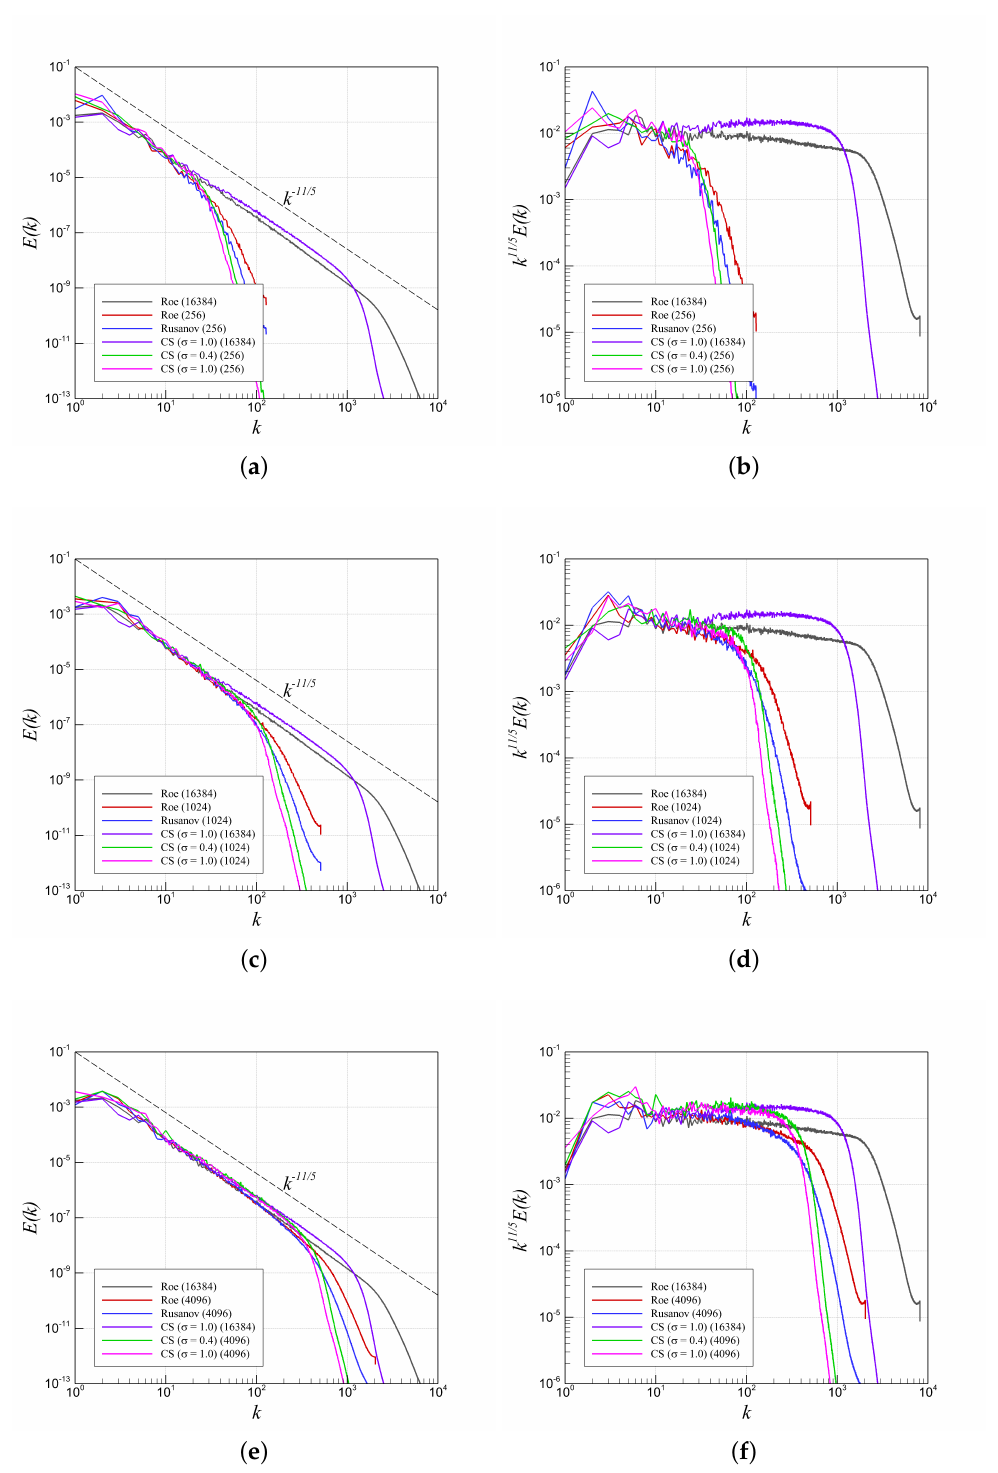
Figure 12. Comparison between ILES and CS+RF models for the RTI problem with multi-mode perturbation at different resolutions; ( a ) density-weighted spectra at 256 × 384 resolution; ( b ) compensated density-weighted spectra at 256 × 384 resolution; ( c ) density-weighted spectra at 1024 × 1536 resolution; ( d ) compensated density-weighted spectra at 1024 × 1536 resolution; ( e ) density-weighted spectra at 4096 × 6144 resolution; ( f ) compensated density-weighted spectra at 4096 × 6144